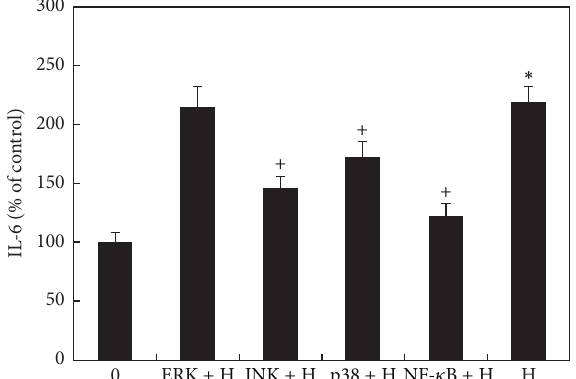
Figure 4: Effects of MAPK and NF- 𝜅 B inhibitors on hyperosmoticity-induced secretion of IL-6 by CE cells. Cells were cultured with isoosmotic medium (0) or hyperosmotic medium (H) with or without various pathway inhibitors, including UO1026 (ERK inhibitor, ERK + H); SP600125 (JNK inhibitor, JNK + H); SB203580 (p38 inhibitor, p38 + H); and BAY11-7082 (NF- 𝜅 B inhibitor, NF- 𝜅 B + H). IL-6 levels in conditioned medium were measured by using IL-6 ELISA kit. Hyperosmotic medium significantly increased IL-6 levels ( ∗ 𝑃 < 0.05 ). JNK, p38, and NF- 𝜅 B inhibitors significantly inhibited hyperosmoticity-induced increase of IL-6 by CE cells ( + 𝑃 < 0.05 ). ERK inhibitors did not affect hyperosmoticity-induced increase of